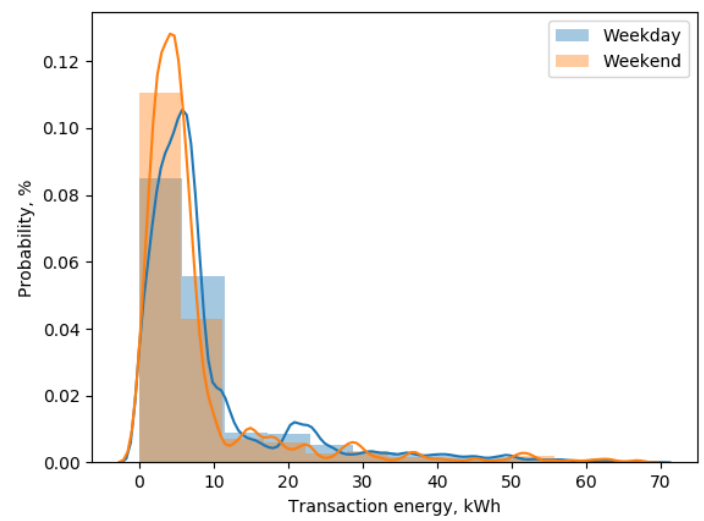
Figure 3. Distribution of the transaction energy for weekdays and weekends in the dataset. Time set to UTC.